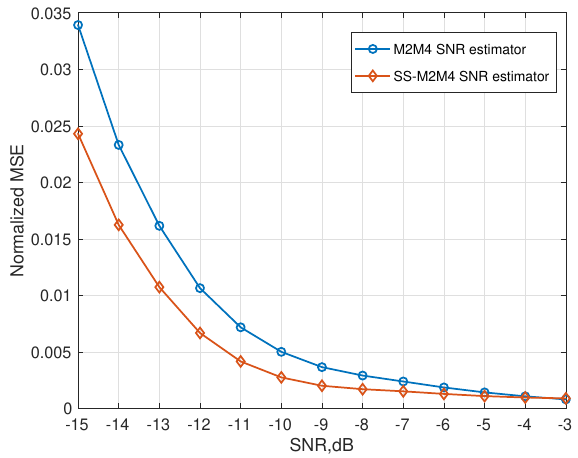
Figure 8. MSE of SS-M2M4 estimator and M2M4